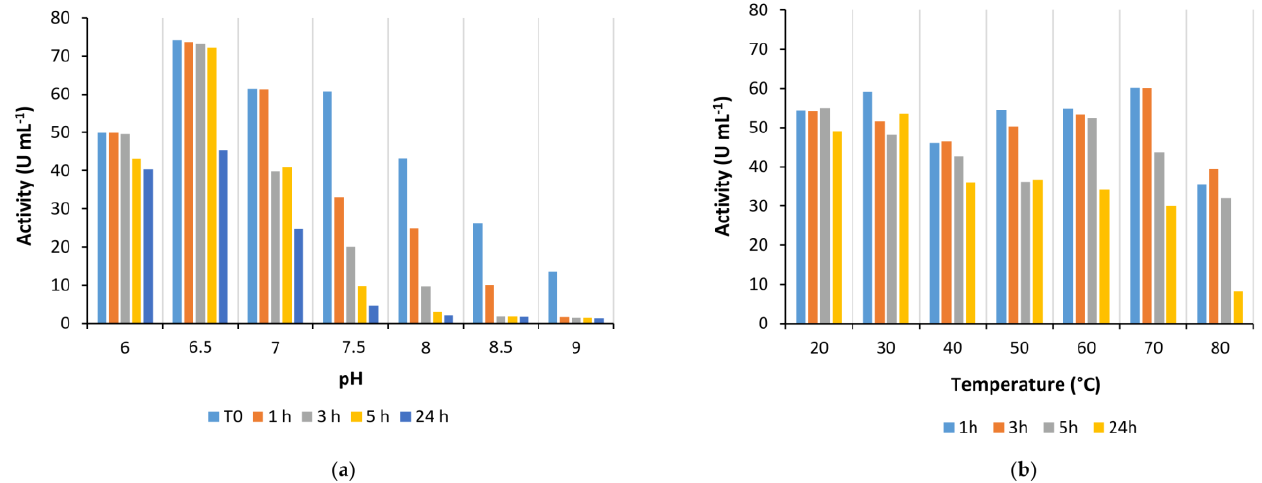
Figure 3. Stability of Is2-SDR at different pH values ( a ) and temperatures ( b ).